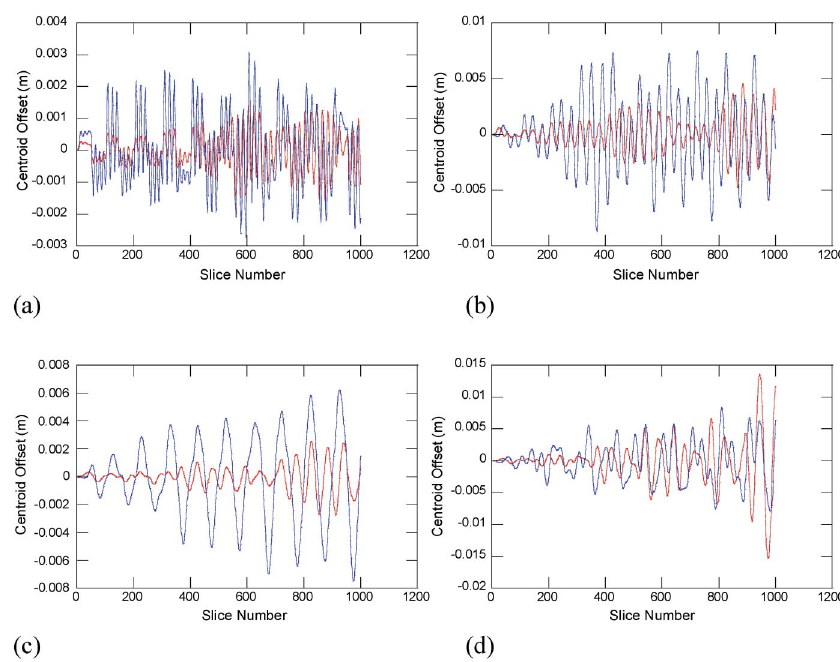
FIG. 33. (Color) Ion centroids at (a) 2.5 m, (b) 5 m, (c) 7.5 m, and (d) 10 m for a 2 msec beam in the downstream transport, for an initial offset period of 200 nsec. The red line is for the horizontal offset and the blue line is for the vertical offset.